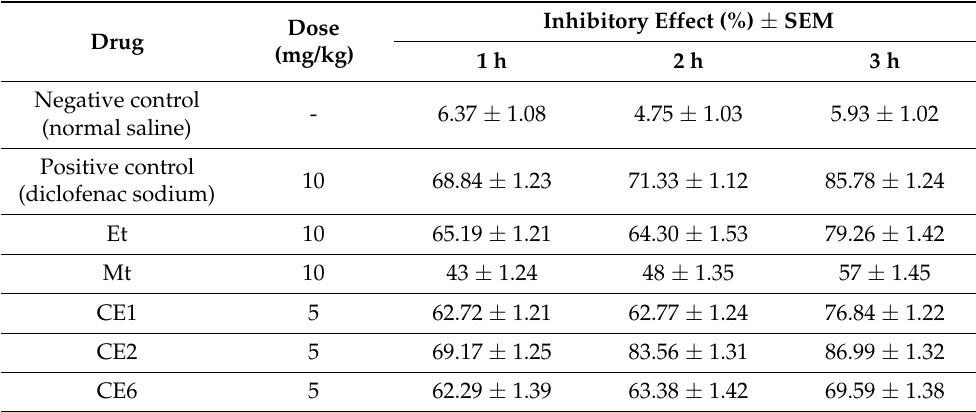
Table 4. In vivo anti-inflammatory activity.